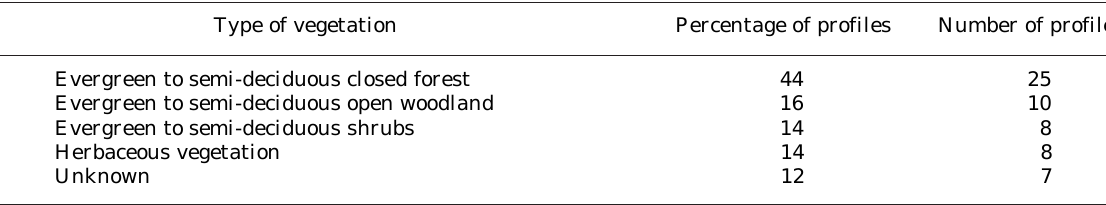
Table 3. Type of original vegetation on the soil sites